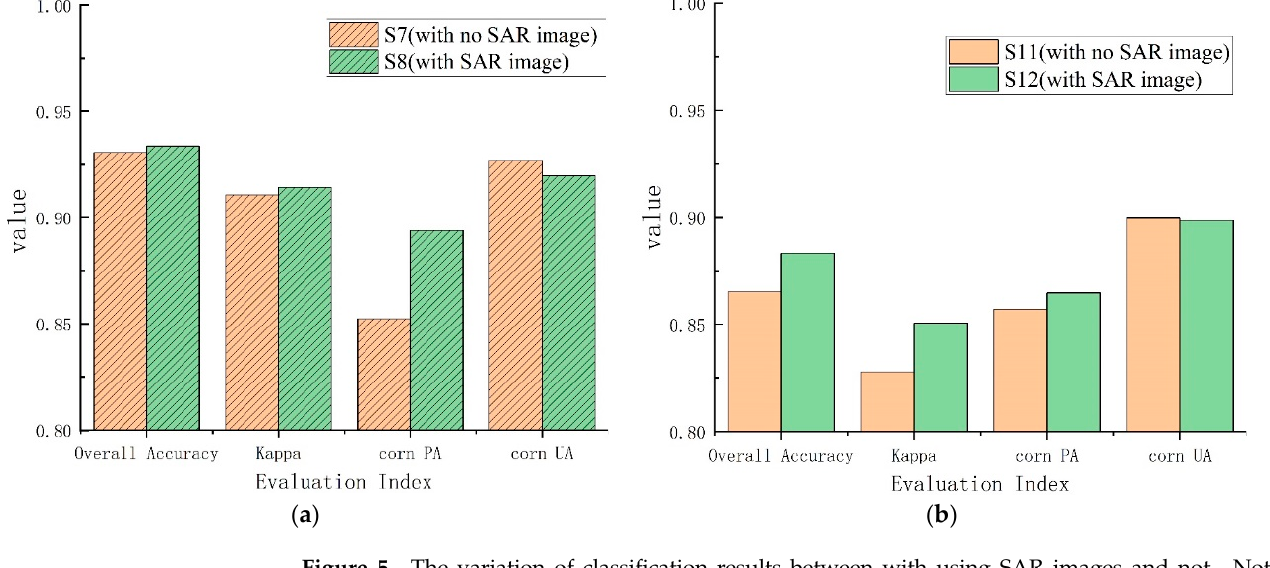
Figure 5. The variation of classification results between with using SAR images and not. Note: Figure ( a ) shows the accuracy comparison of GF images with SAR images and without SAR images. Figure ( b ) shows the accuracy comparison of Sentinel images with SAR images and without SAR images.